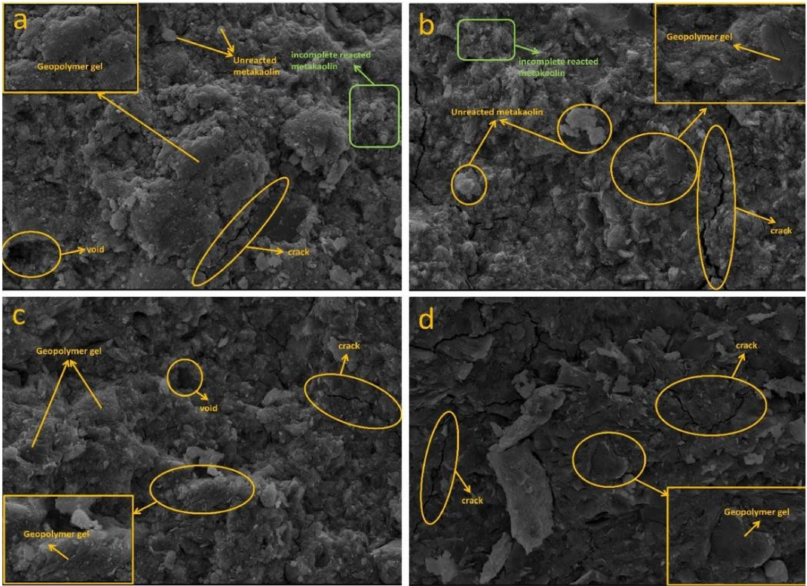
Figure 5. The 28-day SEM microscopic morphology of Na-based geopolymers (N1, N2, N7, and N14 in ( a – d ), respectively).